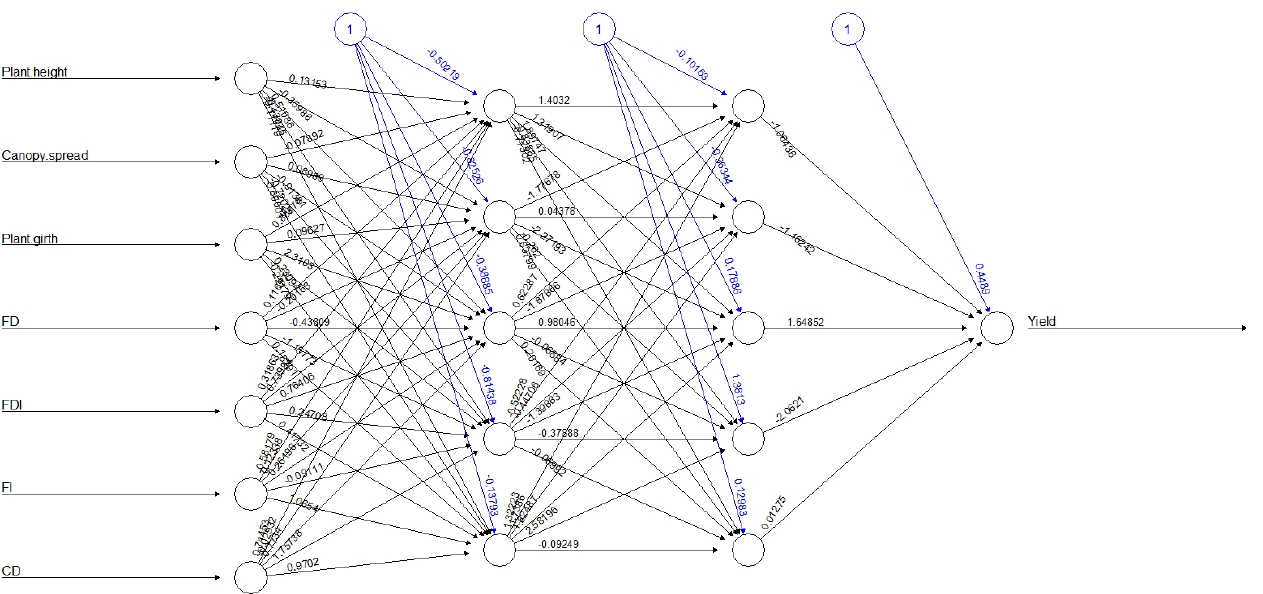
Figure 1. Topology of neural network model for Apple yield prediction.